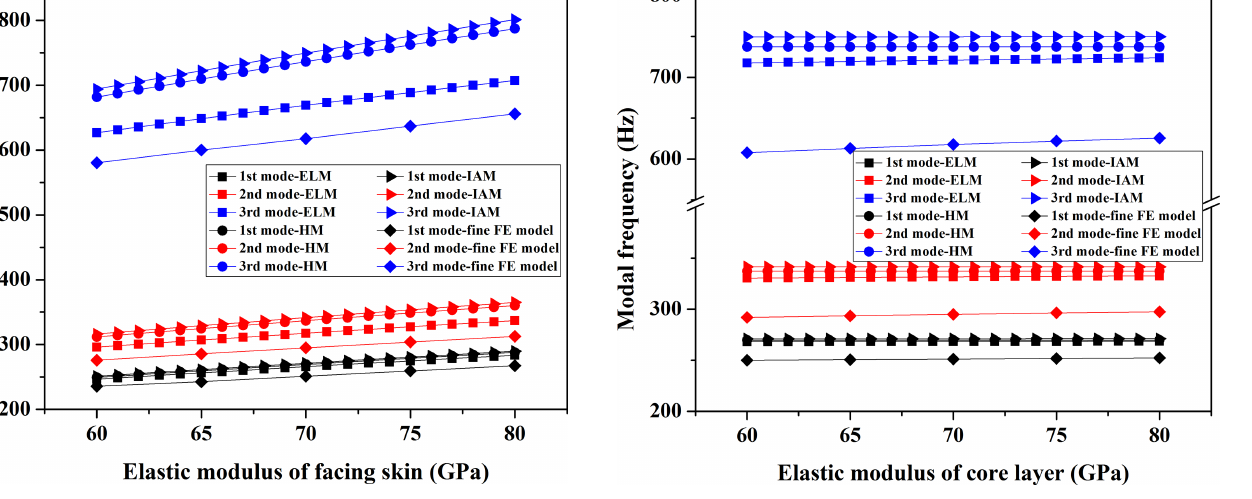
Figure 7. Effect of the elastic modulus of core layer on the dynamic characteristics.